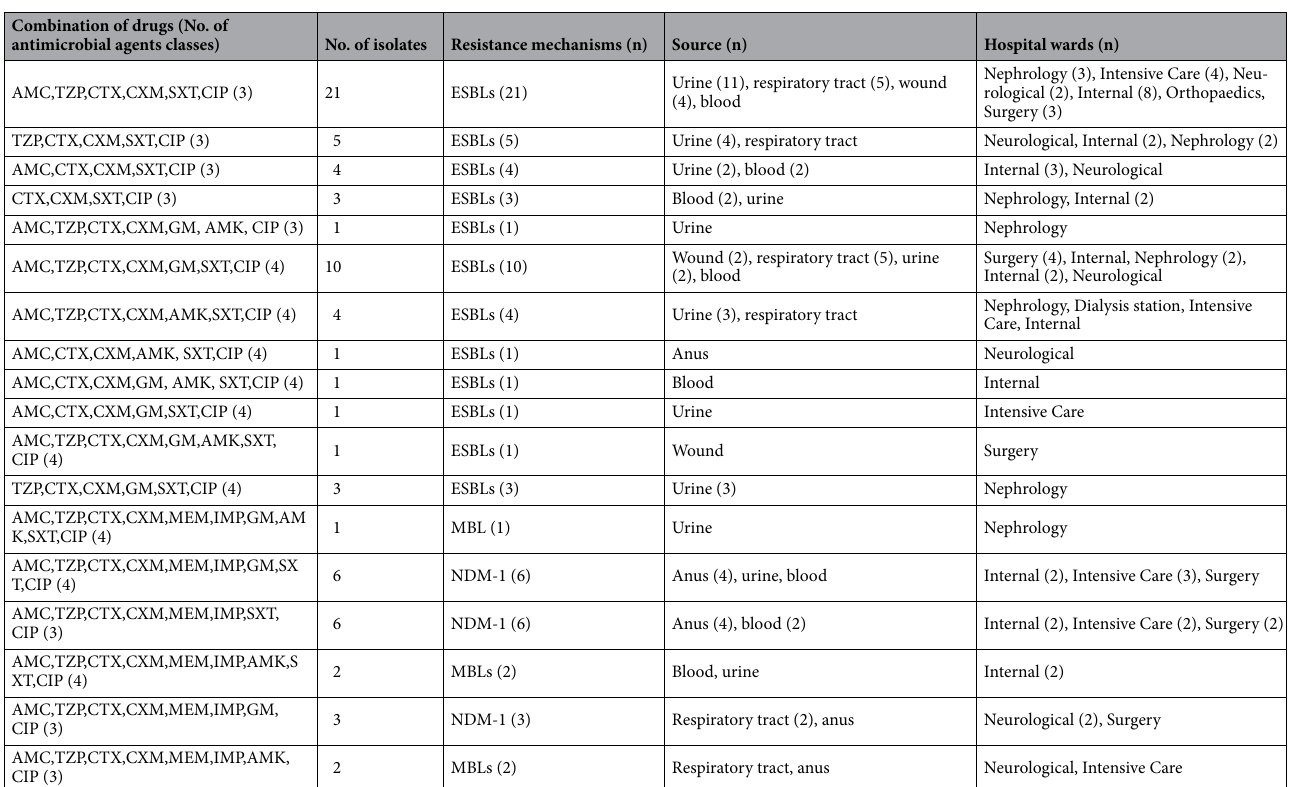
Table 3. Multi-drug resistance pattern of K. pneumoniae isolates from different clinical materials. AMC— amoxicillin plus clavulanic acid, TZP—piperacillin plus tazobactam CTX—cefotaxime,